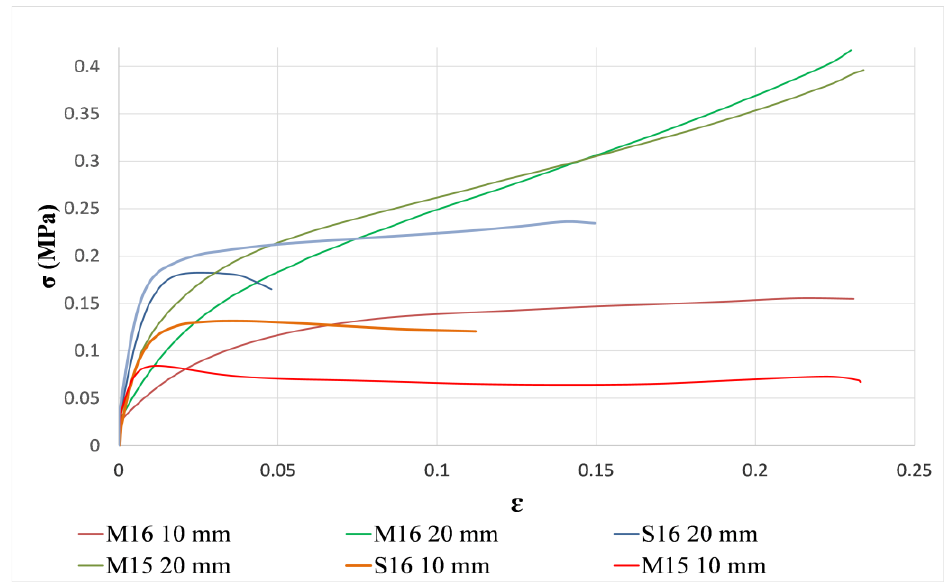
Figure 12. Compressive strength curves of bio-based concrete made from rapeseed plants for different years, harvest locations, and straw sizes.